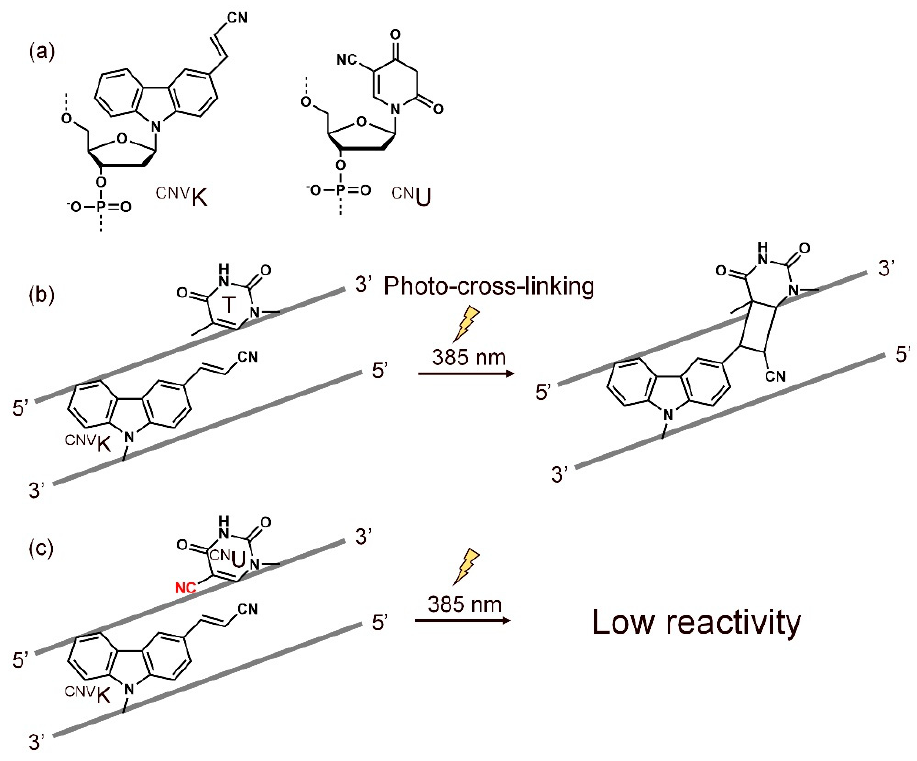
Figure 14. ( a ) Structures of CNV K and CN U. ( b ) Scheme of photo-cross-linking reactions of CNV K and T. ( c ) The lower reactivity between CNV K and CN U suppresses the photo-cross-linking between probes.